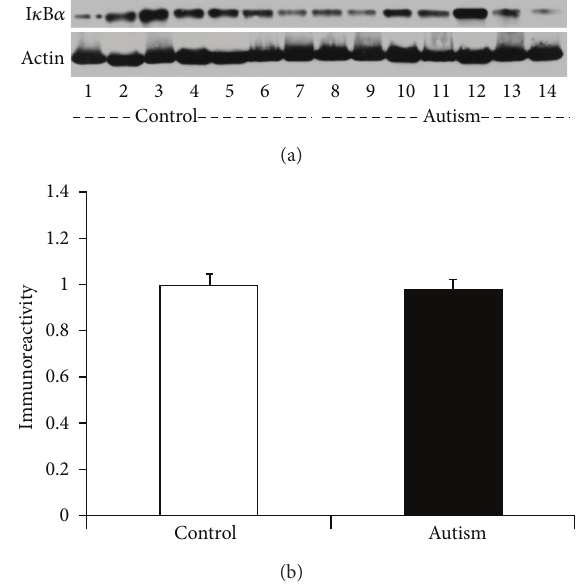
Figure 2: I 𝜅 B 𝛼 inhibitory subunit expression in the cerebellum of autistic subjects. Western blot studies on cerebellar homogenates using I 𝜅 B 𝛼 antibody (dilution 1:1000). Lanes 1–7 represent control subjects and lanes 8–14 represent autistic subjects. The western blot results were quantitated after being normalized by actin. Data are shown as mean ± SE.